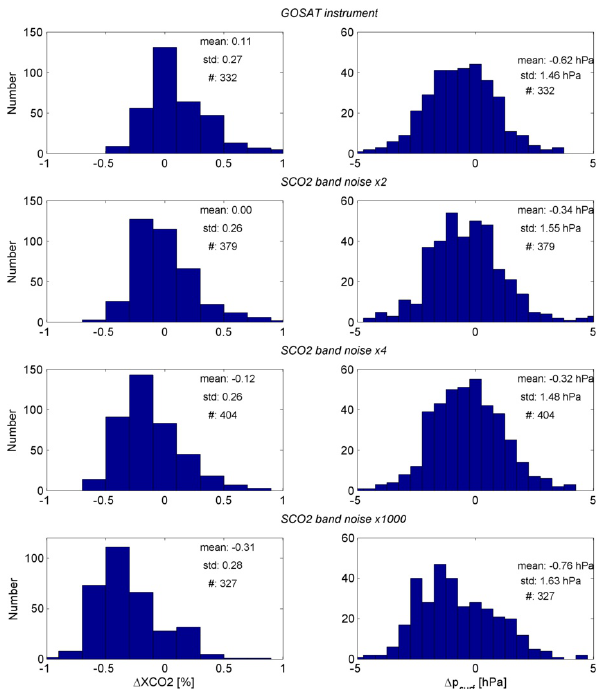
Fig. 8. Histograms of the errors in retrieved X CO pressure (hPa) for different scaling factors of the noise in the strong CO 2 band.